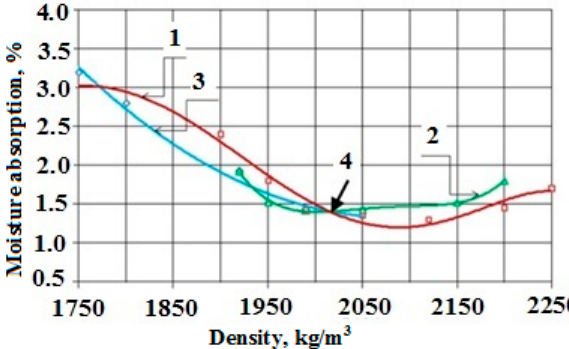
Figure 8. Dependence of moisture absorption on density for a variation of parameters of pressing a composite: 1, molding pressure; 2, time of molding under the pressure; 3, molding speed; and 4, optimum parameters.